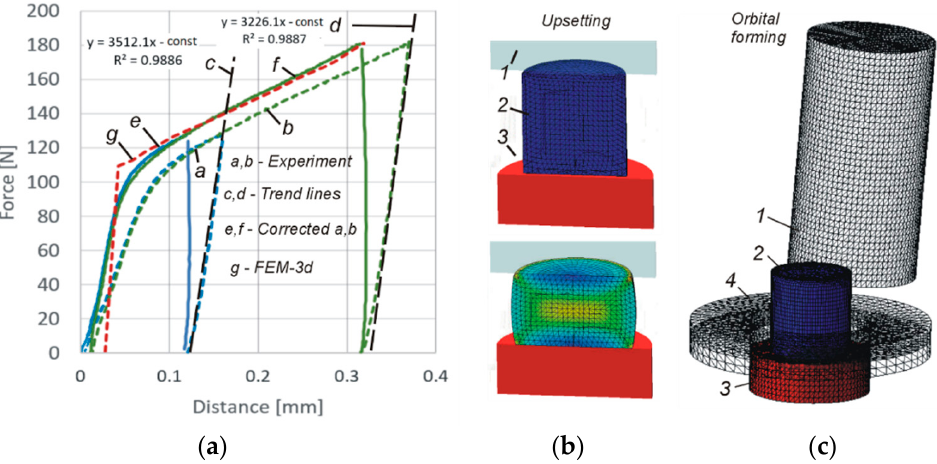
Figure 5. Results of the simple upsetting experiment and FEM-3d modeling: ( a ) process forces and their analysis-description in text; ( b ) FEM-3d model of simple upsetting and equivalent strain distribution; and ( c ) FEM-3d model of orbital upsetting, including the punch (1), specimen (2), anvil (3), and plate (4).